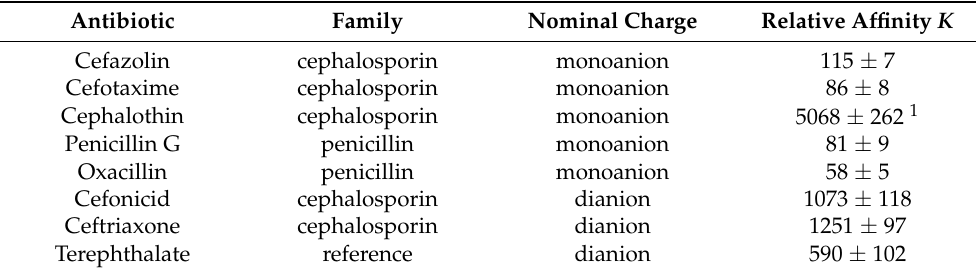
Table 1. Relative binding affinities of antibiotics to PAMAM G5, calculated by nonlinear fitting of a Langmuir-type saturation binding model to the anisotropy profiles from Figure 2. See Figure S3 in the Supporting Information for detailed fitting results.